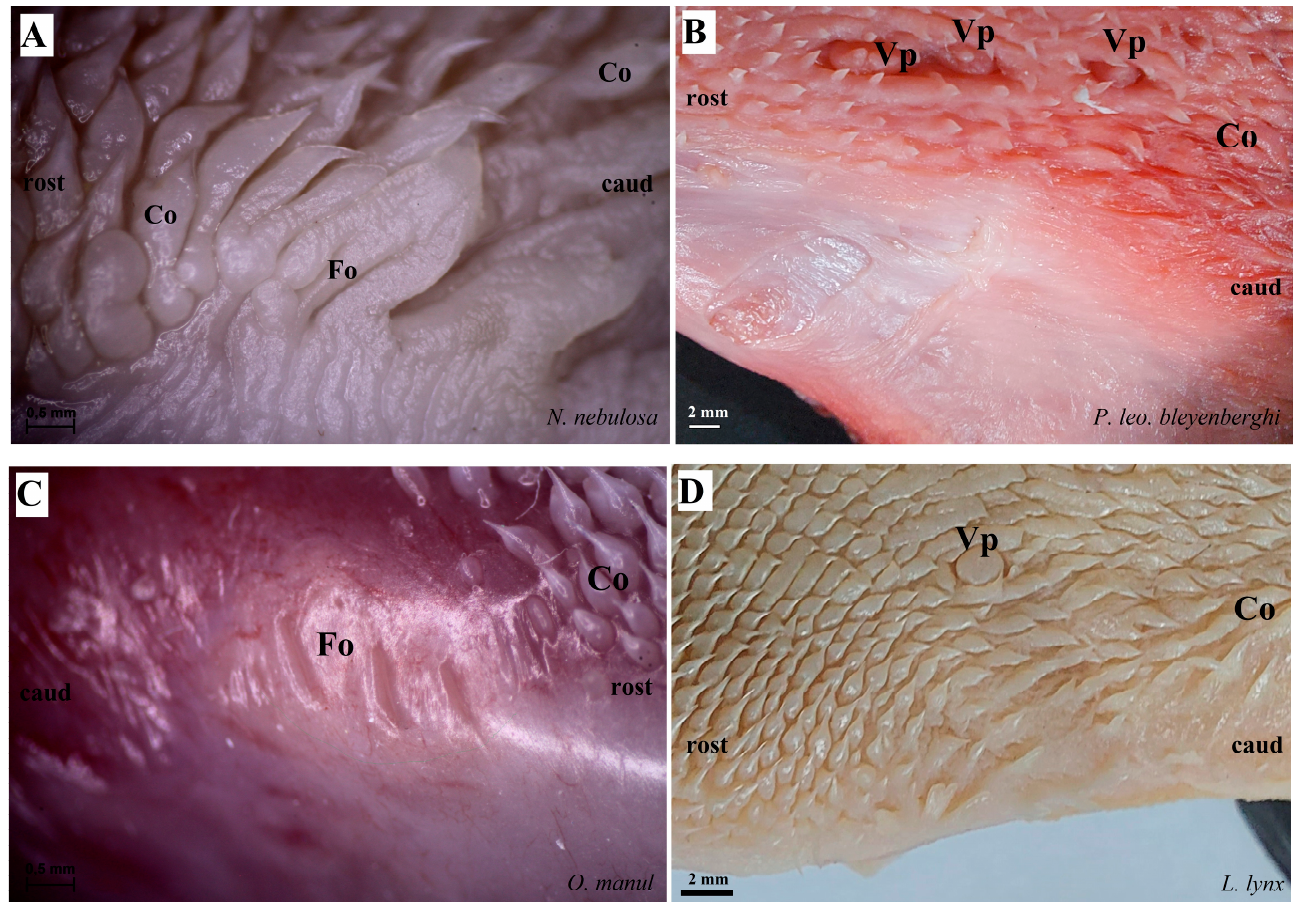
Figure 6. Stereoscopic view of the lateral left ( A , B , D ) and right ( C ) lingual surface between the body and root of the tongue in four species of undomesticated Felidae: N. nebulosa ( A ), P. leo bleyenberghi ( B ), O. manul ( C ) and L. lynx ( D ). ( A ) Several smooth folds separated by parallel grooves within the foliate papillae area. ( B ) Lack of the foliate papillae. ( C ) Smooth folds separated by five grooves, which form the foliate papillae. ( D ) Lack of the foliate papillae. Bar = 2 mm (B,D); bar = 0.5 mm (A,C). Abbreviations: caud—caudal orientation of the mechanical lingual papillae, Co—conical pa- pilla, Fo—foliate papilla, rostr—rostral orientation of the mechanical lingual papilla, Vp—vallate papilla.